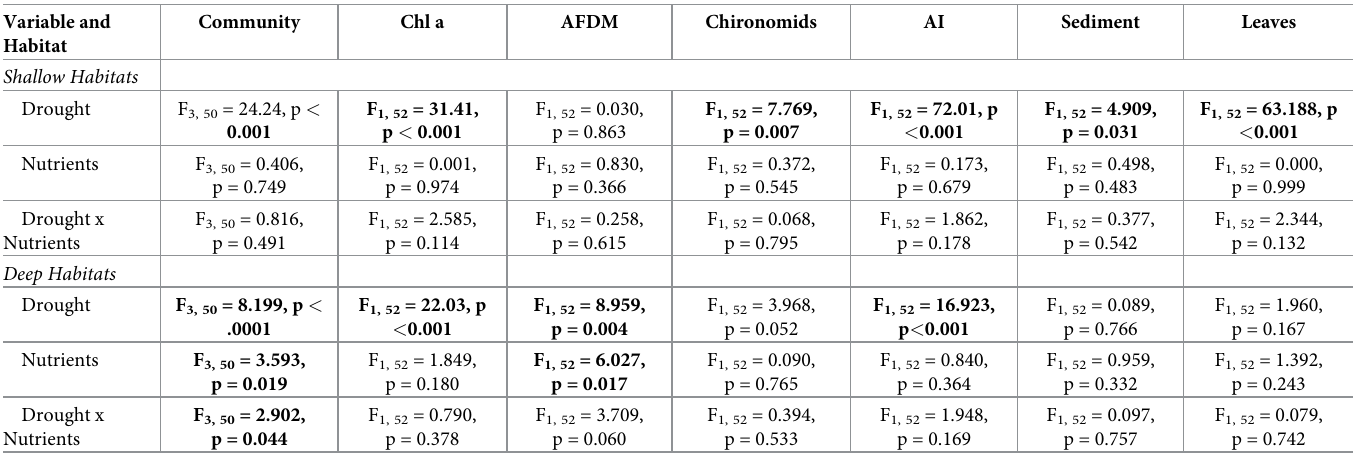
Table 2. Probability values associated with multivariate analysis of variance (MANOVA) and analyses of variance (ANOVA) for effects of drought and nutrient enrichment on benthic community variables (chironomid density, ash-free dry mass [AFDM], autotrophic index [AI]). Variable and